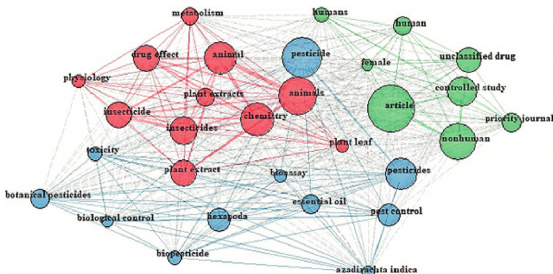
Figure 2: Keyword co-occurrences network of the top 30 keywords on green pesticide research. The circle size of the keywords rep- resents the frequency of occurrence in articles. The thickness of the line between any two keywords displays the degree of